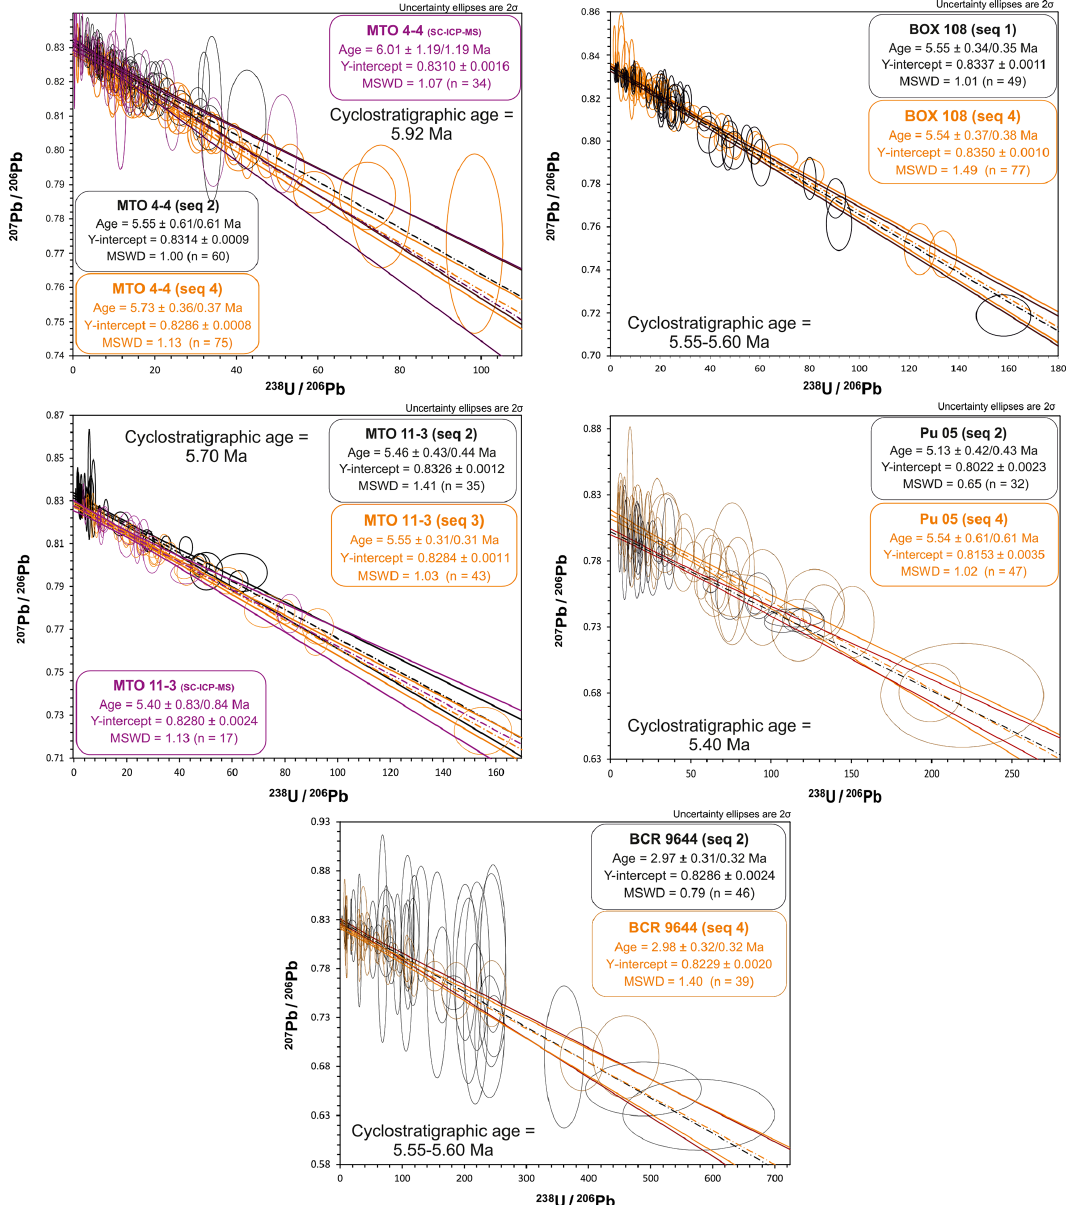
Figure 3. Tera–Wasserburg diagram ( 207 Pb / 206 Pb vs. 238 U / 206 Pb) for samples MTO 4-4, MTO 11-3, BOX 108, Pu 05 and BCR 9644. The blue ellipses and error envelope in samples MTO 4-4 and MTO 11-3 correspond to the analyses with the SC-ICPMS, while orange and black refer to two independent sessions with the MC-ICPMS. Both propagated within-session uncertainties and the expanded uncertainties are ± 2 σ